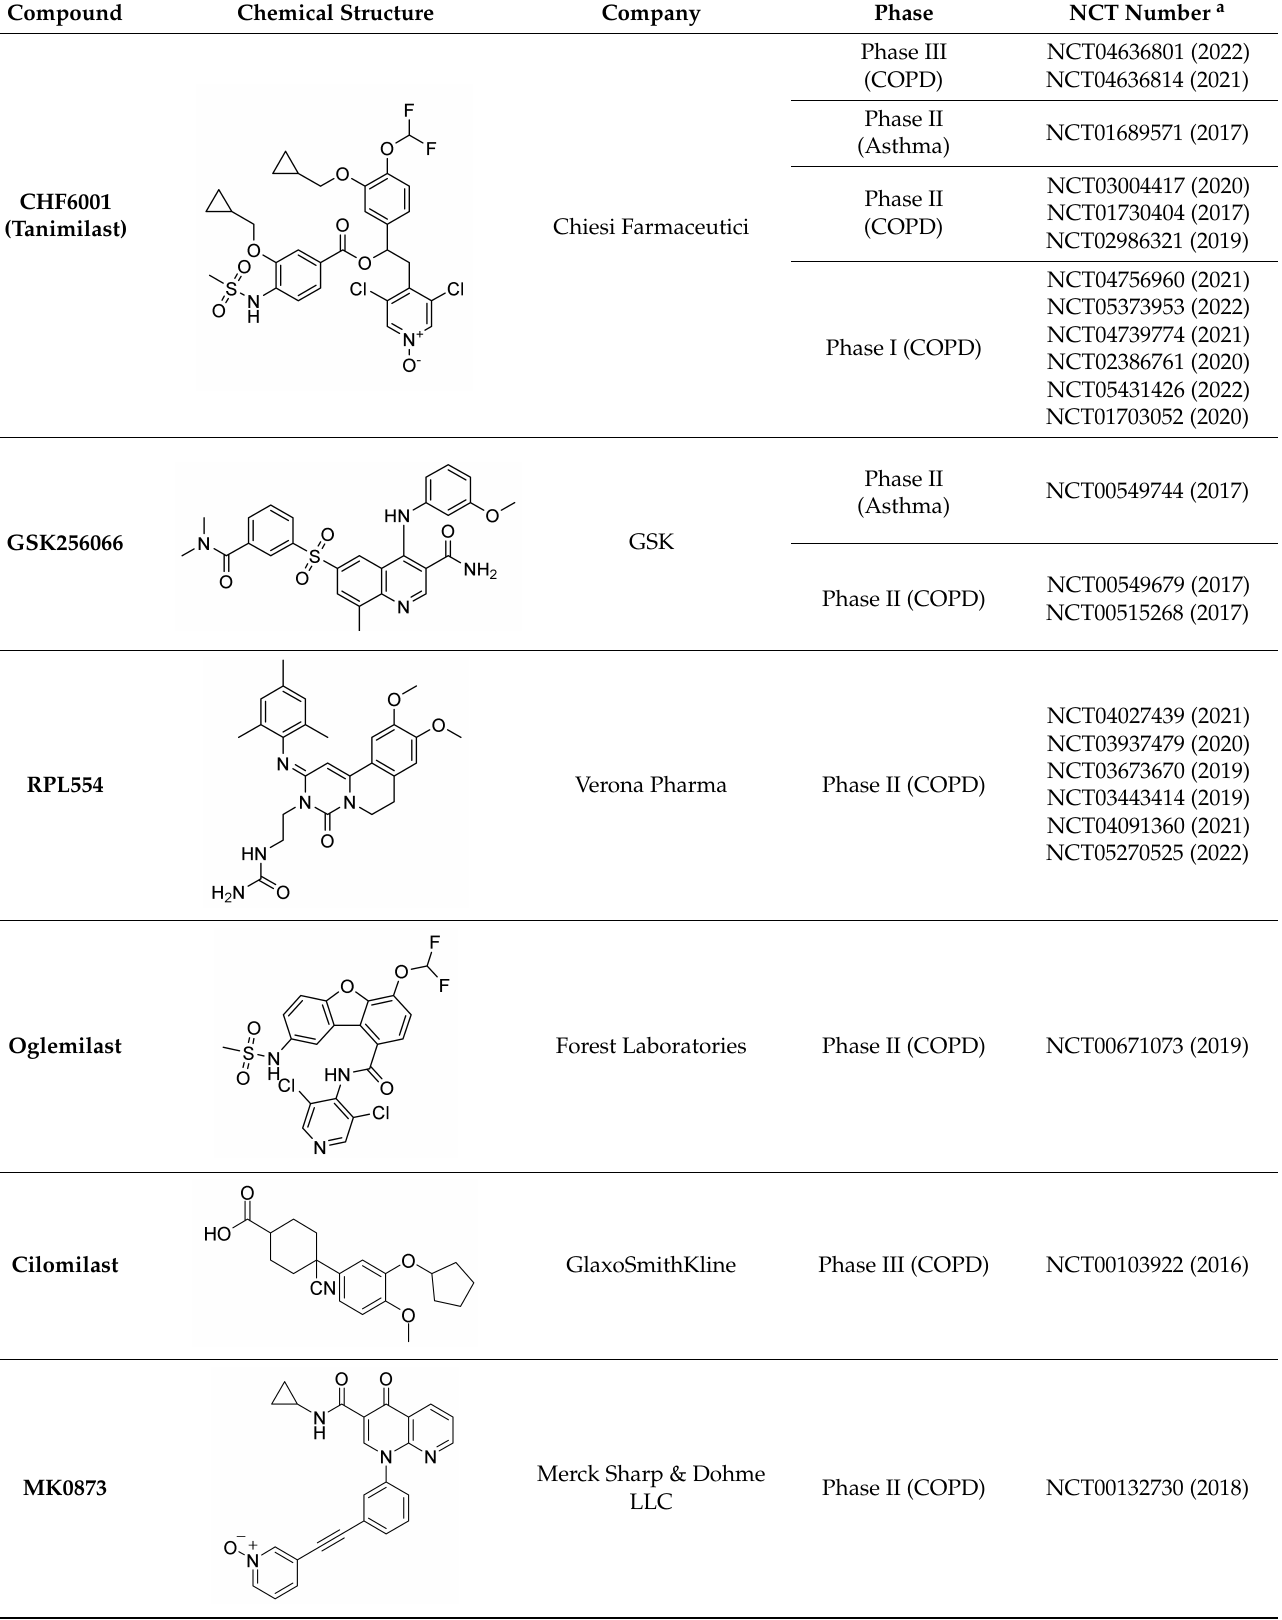
Table 1. PDE4 inhibitors under development for the treatment of respiratory inflammatory